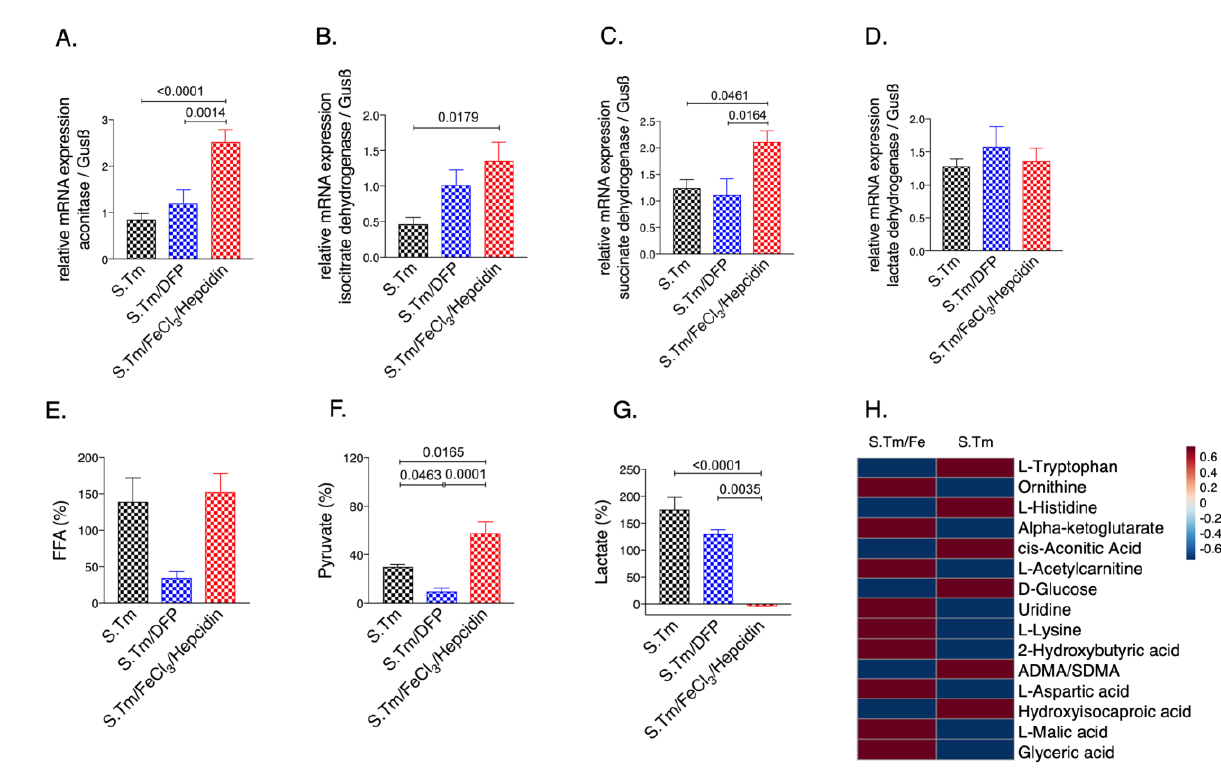
FIGURE 3: Effects of iron perturbations on TCA enzyme expression and metabolite concentrations in Salmonella infected macrophages. Cells were pre-treated with FeCl 3 /hepcidin (50 µM/ 1µg/ml, respectively) or DFP (50 µM) for 6 hours or left untreated prior to infection with Salmonella (MOI of 10) as detailed in methods. Expression of aconitase (A) , isocitrate dehydrogenase (B) , succinate dehydrogenase (C) and lactate dehydrogenase (D) mRNA relative to the house keeping gene was determined by qRT-PCR in untreated control cells (ctrl) or infected cells after 24 hours. Metabolite levels of lactate (E) , free fatty acids (F) and pyruvate (G) were determined in the cell supernatant after 24 h of infection. A selection of 15-top metabolites (raw-wise) from the metabolomics analysis of cellular supernatants is shown in the heatmap (H) , where samples in each group were averaged (column-wise, S.Tm/Fe n=13; S.Tm n=13). Representative data from three independent experiments performed in duplicates or triplicates are shown. Data are shown as relative changes as compared to the control. Graphs show means ± SEM. One- way ANOVA with Tukey’s multiple comparison correction was performed. Exact p -values are indicated in the